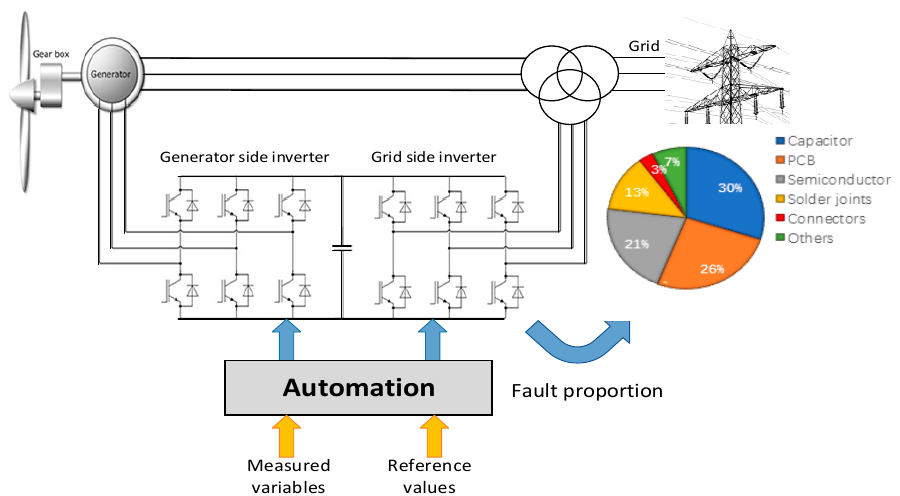
Figure 8. WT power electronic device and fault proportion.